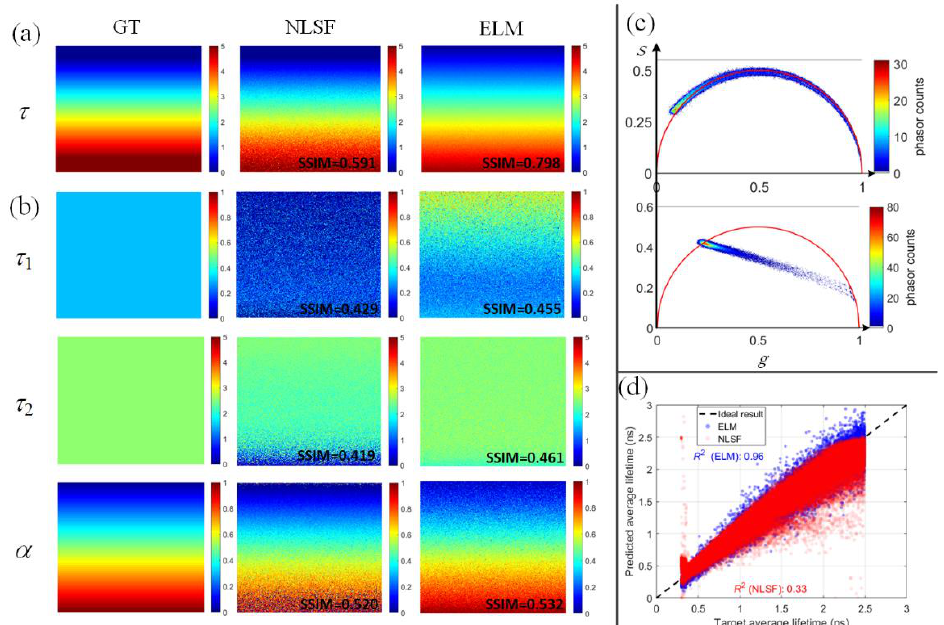
Figure 3. Lifetime parameters’ estimation results, photon counts for each pixel were randomly picked between 25 and 500. ( a ) The estimated single lifetime using a mono-exponential decay model, where τ ∊ [0.1, 5] ns from top to down in the image. ( b ) The two estimated lifetimes using a bi-exponential decay model where τ 1 = 0.3 ns, τ 2 = 3 ns, and α ∊ [0, 1] from the top down. ( c ) Two phasor plots of ground truth distributions of ( a , b ). ( d ) Prediction accuracy and R 2 of τ A from ELM and NLSF, with τ 1 = 0.3 ns and τ 2 = 2.5 ns, respectively.